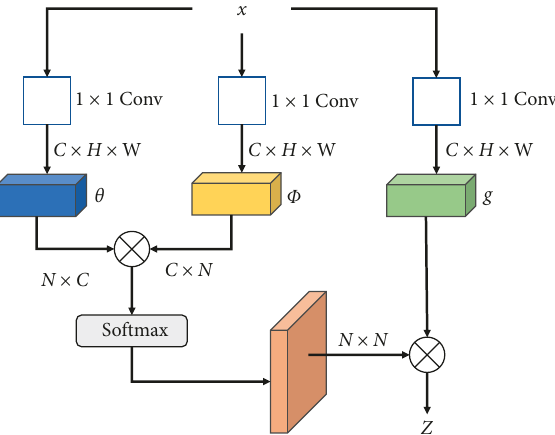
Figure 4: Structure of nonlocal neural network. C , H , and W correspond to dimensions, where N � H × W.